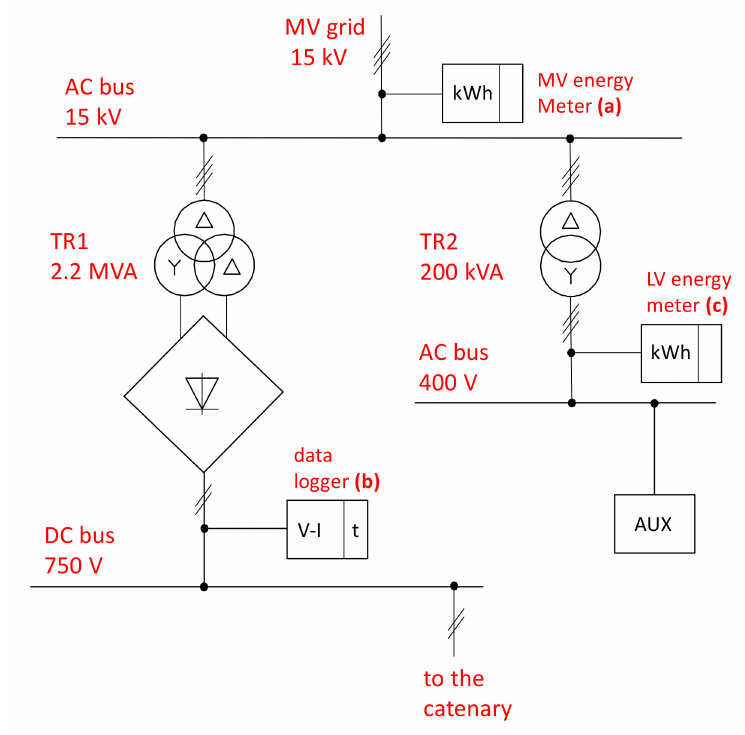
Figure 3. Scheme of ESS, including measurement system.